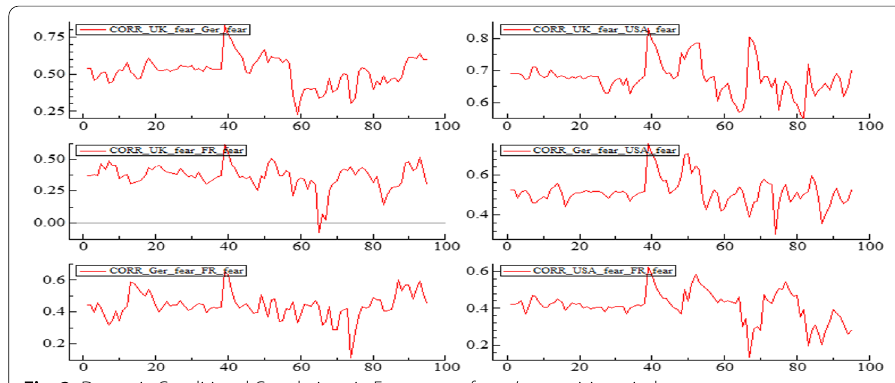
Fig. 2 Dynamic Conditional Correlations in European refugee’s pre-crisis period